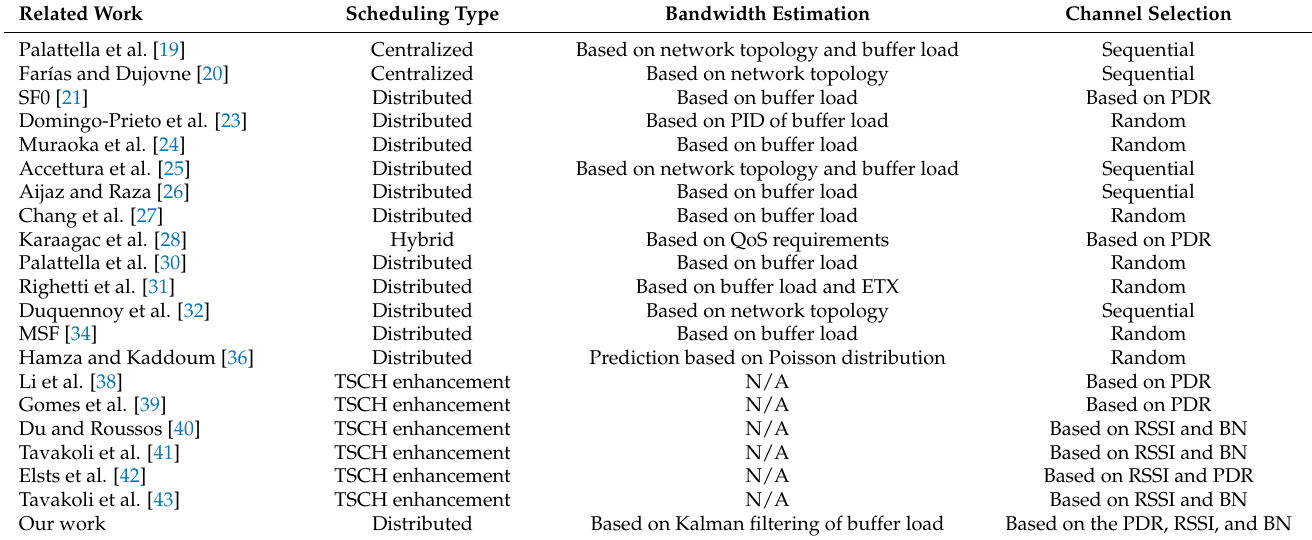
Table 1. Related work comparison. SF0, Scheduling Function Zero; MSF, Minimal Scheduling Function; BN, Background